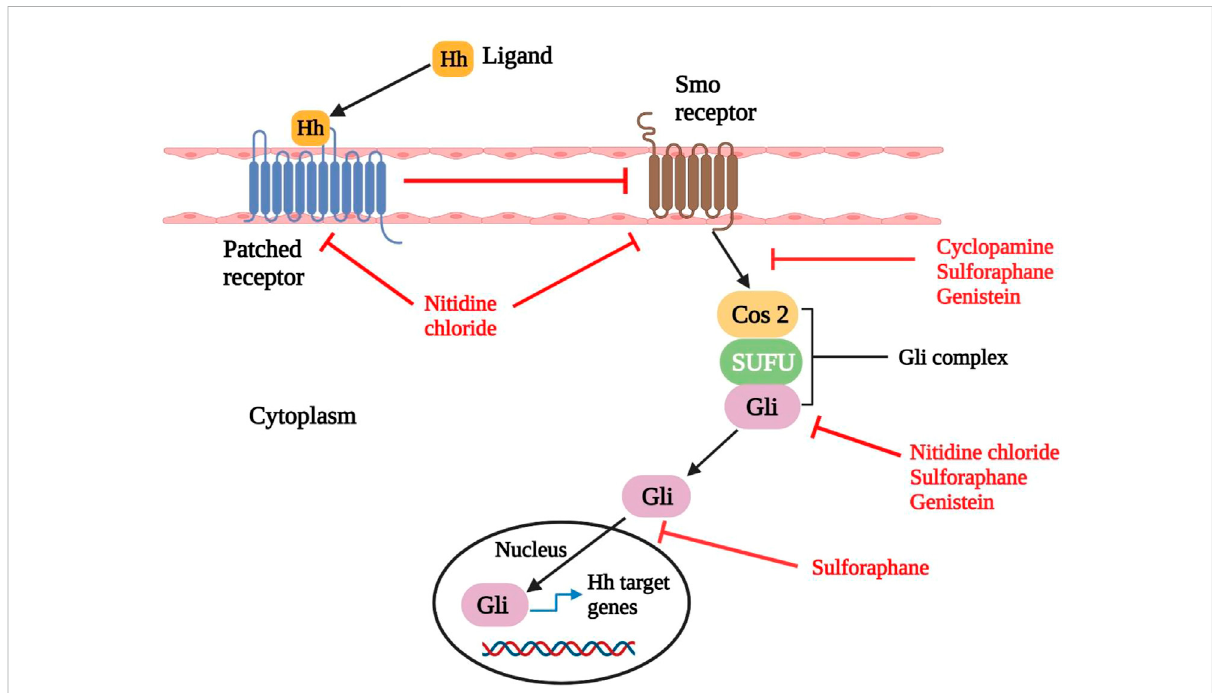
FIGURE 3 Hedgehog signaling and its interference in natural compounds. Upon binding of Hedgehog ligand (Hh) to Patched receptor, Smo is activated (Pathched generally inactivates Smo when it is not engaged with ligand). Then Smo brings about the translocation of Gli protein into the nucleus, subsequently causes the transcription of downstream genes. Compounds such as cyclopamine and genistein decrease the expression of Smo. WhereasnitidinechloridedownregulatestheexpressionofbothSmoandPatchedreceptors.Ontheotherhand,sulforaphane,nitidinechloride and genistein decrease the expression of Gli protein. Sulforaphane also reduces the expression of Smo, Gli and inhibits the nuclear translocation of Gli. Smo: Smoothened; Cos 2: Costal-2; SUFU: Suppressor of fused homolog; Hh: Hedgehog ligand (Skoda et al., 2018; Das et al.,